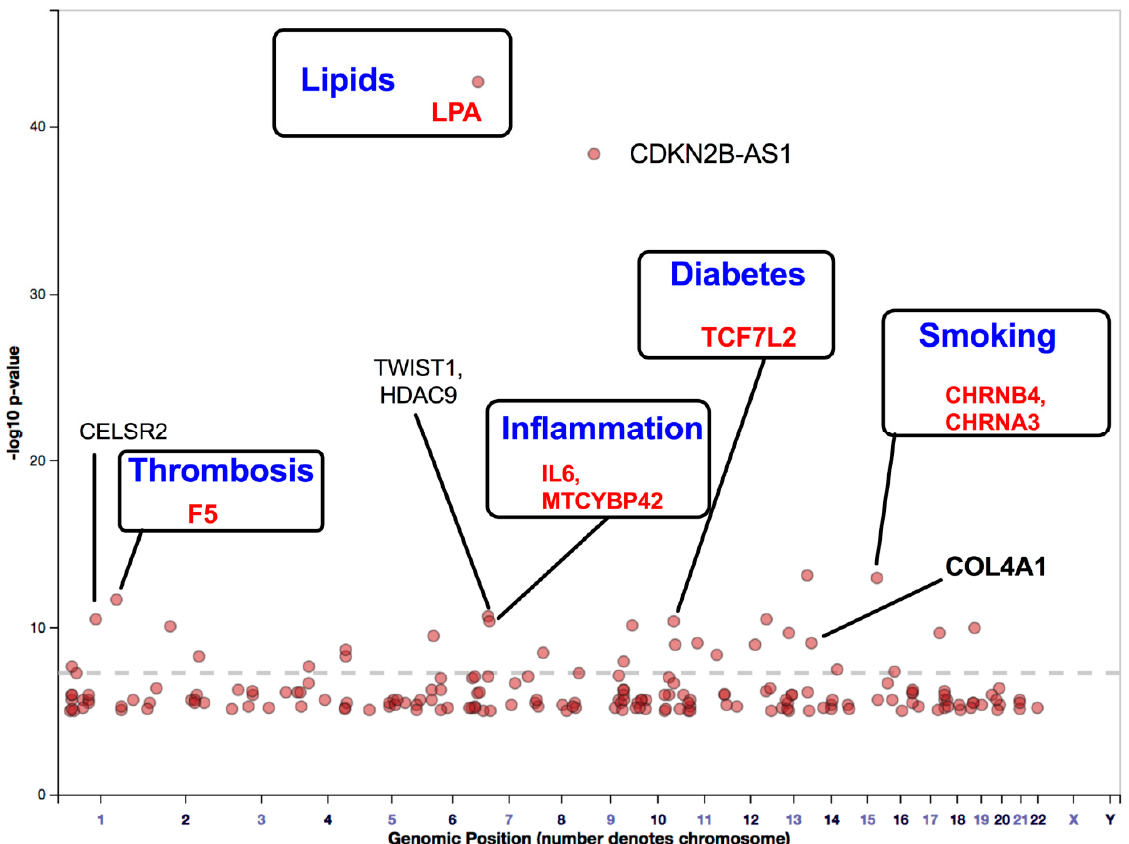
Figure 3. Gene loci associated with PAD identified through GWAS. This figure was modified from the GWAS catalog database with 261,600 patients with PAD. The seven GWAS have been registered as PAD traits (study accession # GCST000720, GCST002504, GCST003154, GCST009133, GCST009134, and GCST008474 downloaded on 18 January 2021). Here, we show a possible improvement of five genes that may reduce disease-development risk and enhance stem cell therapy efficacy. Abbreviations: PAD, peripheral arterial disease; GWAS, genome-wide association studies.